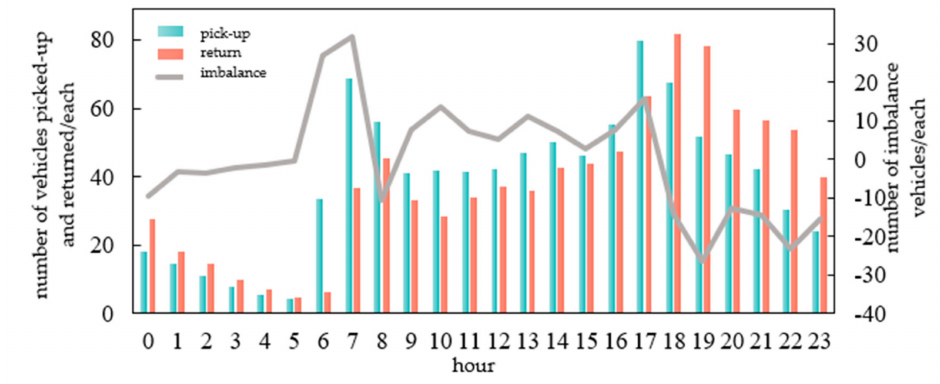
Figure 3. Number of vehicles picked -up and returned in different periods on